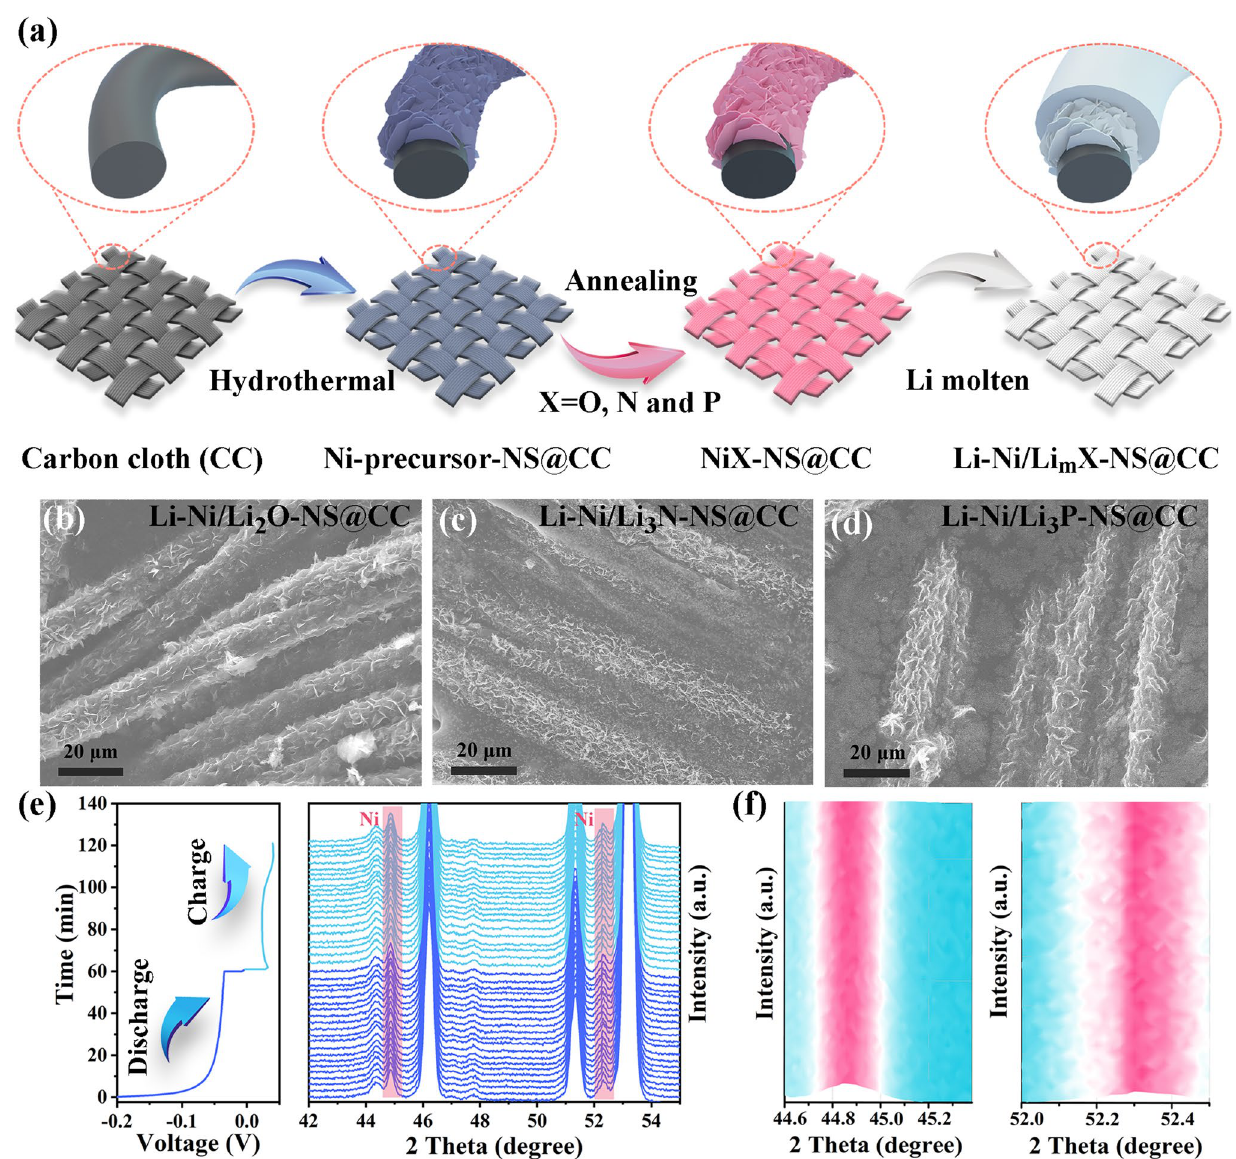
Fig. 2 a Schematic diagram of the fabrication procedure of the Li-Ni/Li m X-NS@CC. The SEM images of b the Li-Ni/Li 2 O-NS@CC, c the Li-Ni/Li 3 N-NS@CC, and d the Li-Ni/Li 3 P-NS@CC. e In situ XRD patterns of the Li-Ni/Li 3 N-NS@CC electrode during the discharge and charge process. f Mountain-like peak images of